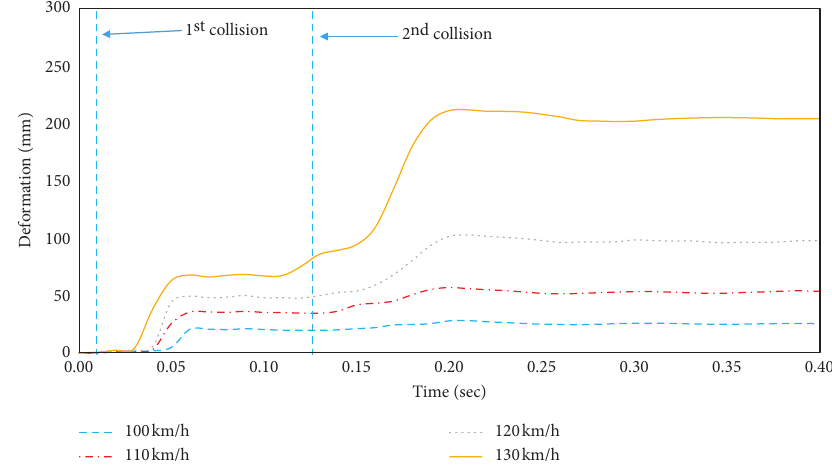
Figure 14: Deformation-time history graph at the rear side of the impacted area (column type